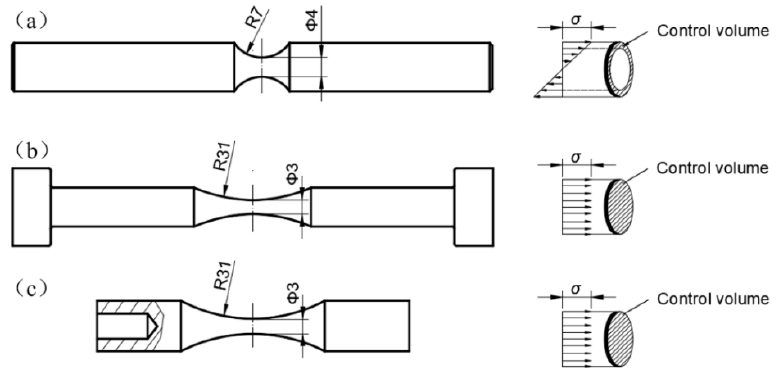
Figure 9. Schematic of control volume for the three types of specimens under a given loading: ( a ) RB specimen; ( b ) EA specimen; ( c ) UA specimen.